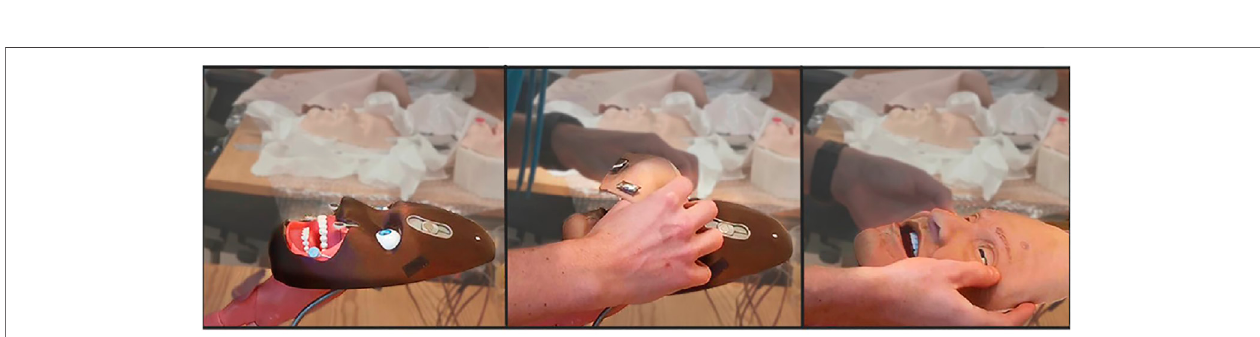
FIGURE 2 | Modular face design for changing the visual appearance using interchangeable face skins.